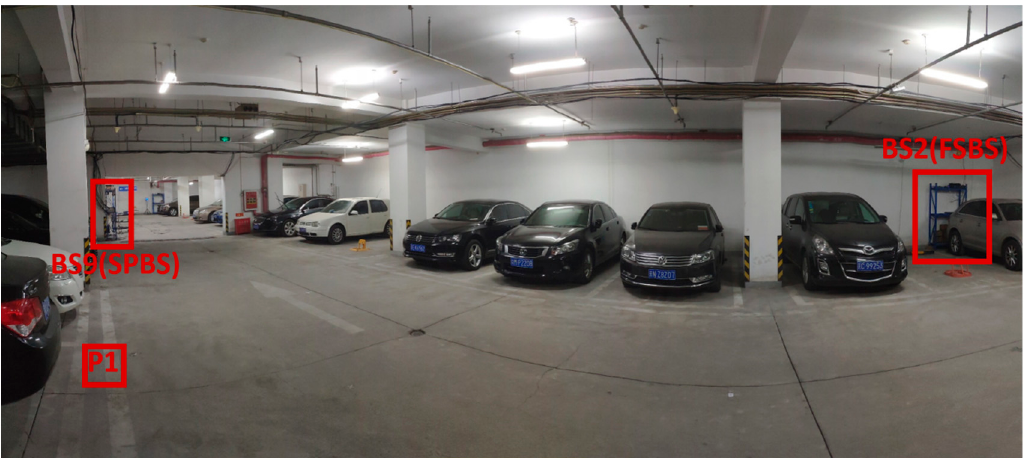
Electronics 2019 , 8 , x FOR PEER REVIEW Figure 15. Realistic picture of the test field. Figure 15. Realistic picture of the test field.